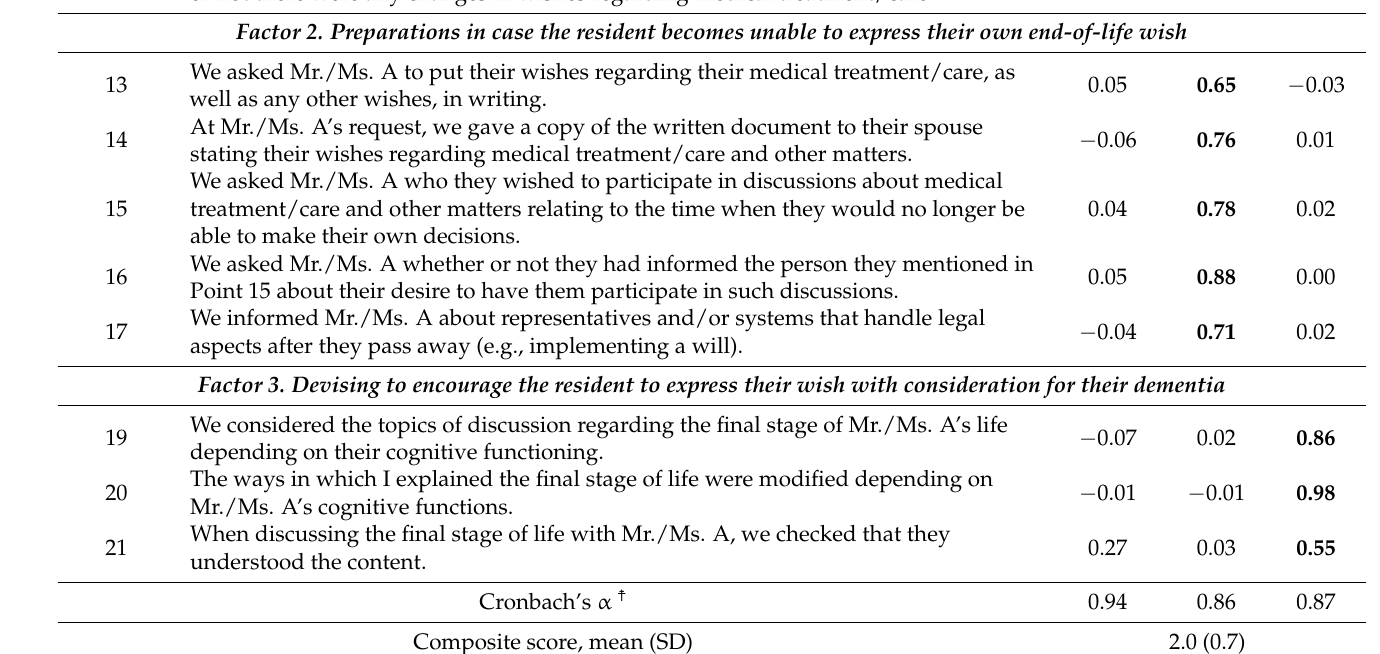
Note : ACP, advance care planning; ACP-PI, ACP Practice Inventory; SD, standard deviation. Italics indicate factor names. Exploratory factor analysis: promax rotation, factor loading >0.45. Items with factor loadings of 0.45 or higher and belonging to a factor are expressed in bold, and each factor is enclosed in a frame. Bartlett’s sphericity test was significant ( χ 2 = 3244.2, df = 153, p < 0.01), and